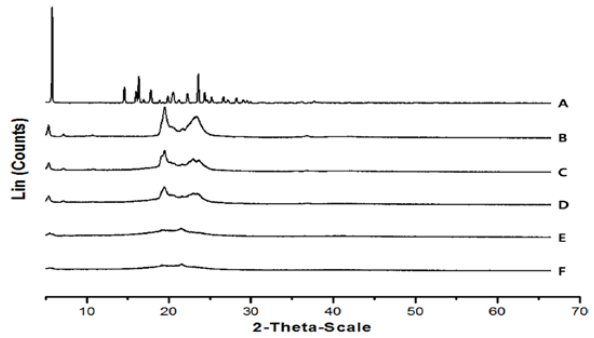
Figure 6. XRD patterns of ( A ) PR only; ( B ) GMS; ( C ) lipid melt; ( D ) PR–lipid melt; ( E ) freeze-dried blank-NLCs; ( F ) freeze-dried PR-NLCs.